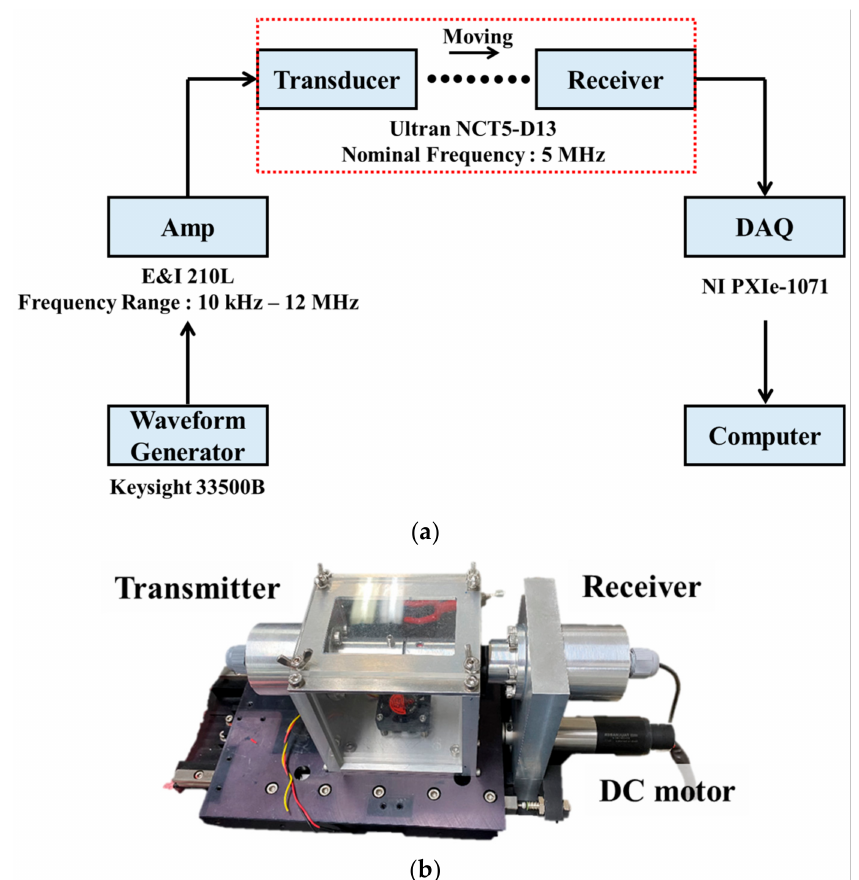
Figure 2. Ultrasonic multiple scattering hardware: ( a ) schematic illustration of the experimental setup, and ( b ) picture of moving platform using